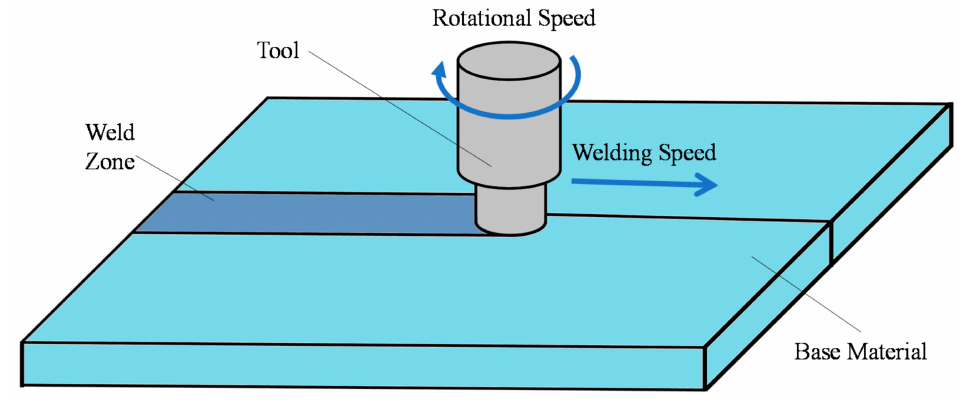
Figure 1. A schematic of the fundamental working process of the friction stir welding